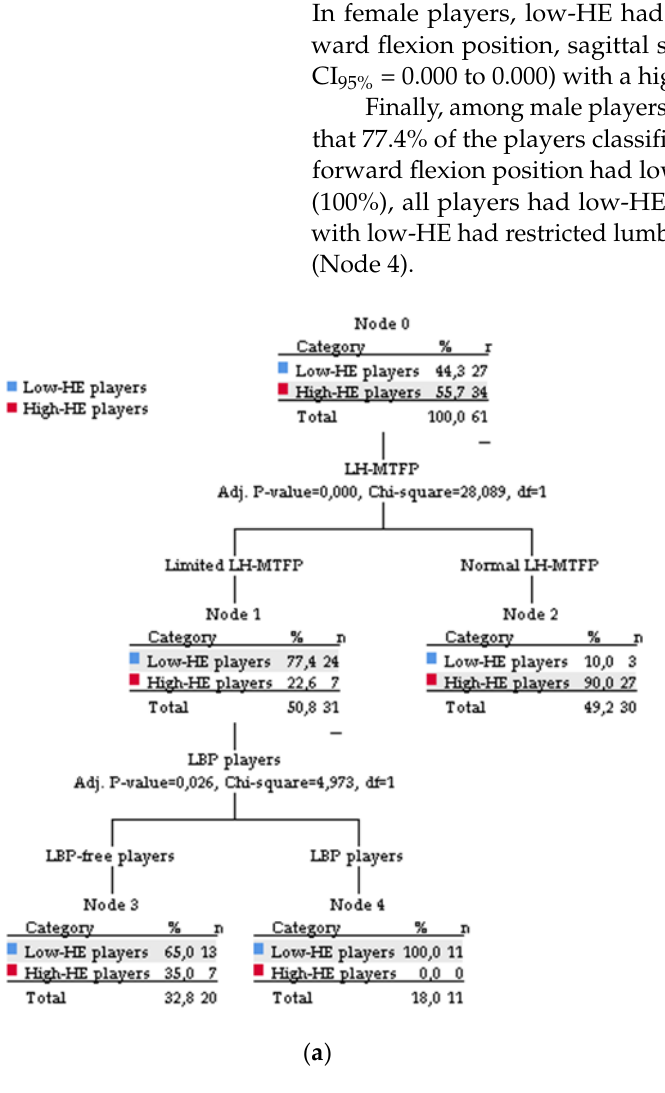
Figure 3. Decision tree analysis of the variables measured in male ( a ) and female ( b ) soccer and basketball players. The cutoff values for male and females were 71° and 75°, respectively.